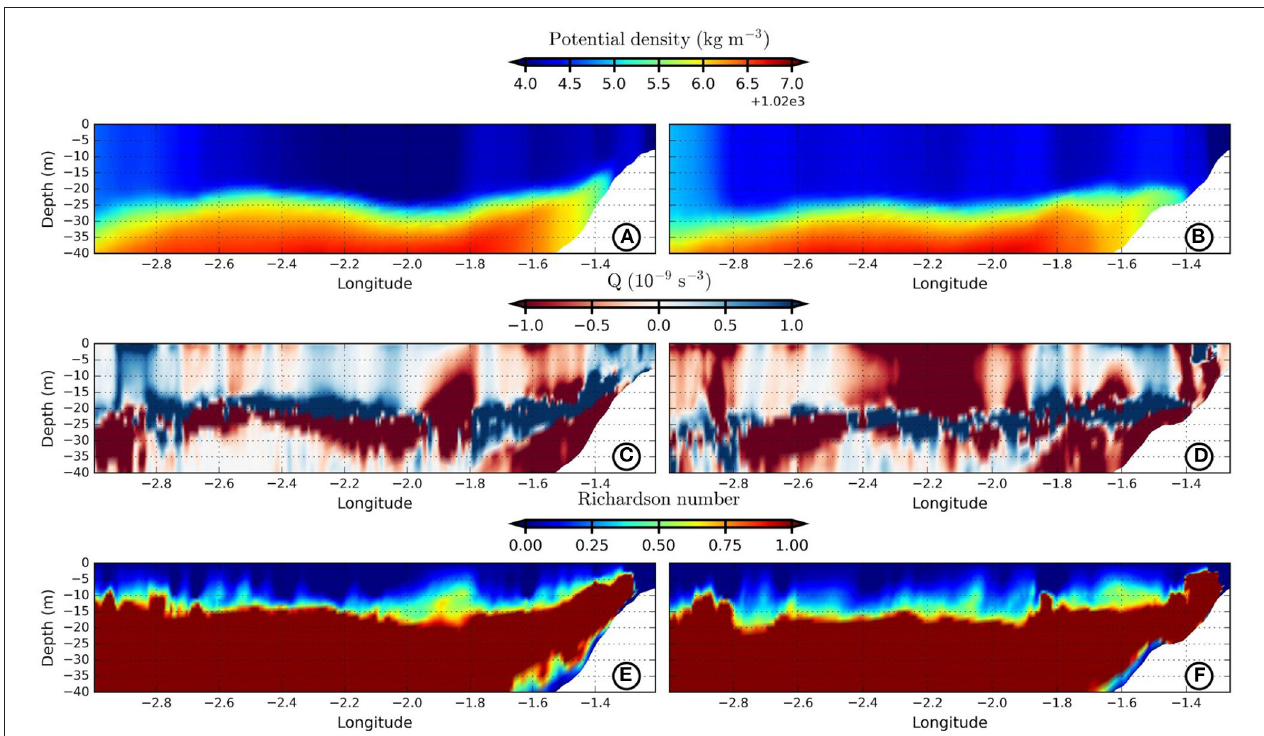
FIGURE 10 | Snapshot August (12/08/2008 at midday) of: the Potential density in section 1 (A) and in section 2 (B) (cf. Figure 7 ), the PV in section 1 (C) and in section 2 (D) and the Richardson number in section 1 (E) and in section 2 (F) .